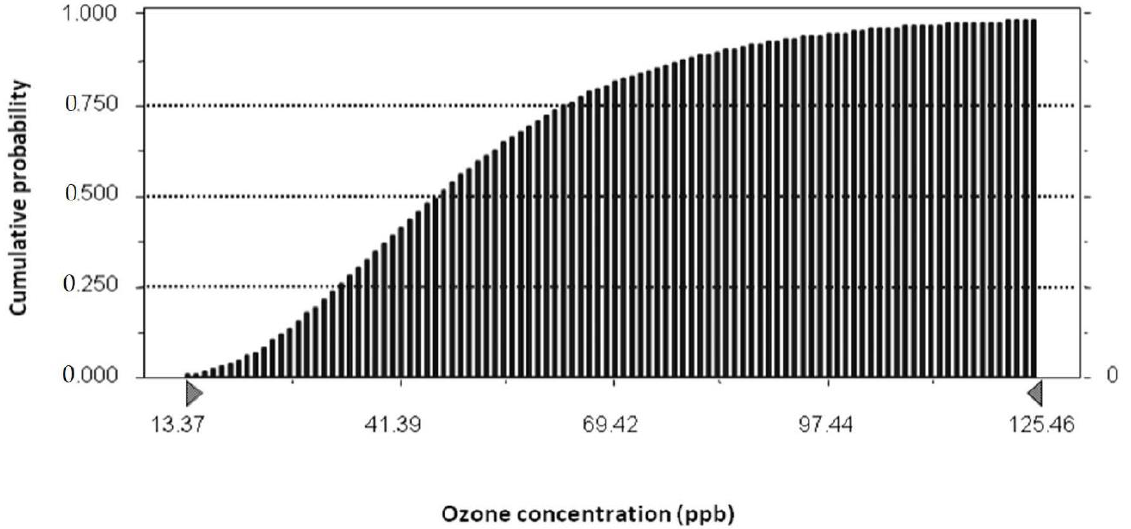
Figure 3. Monte Carlo analysis results reached after 20,000 simulation trials, showing the cumulative probability plot for ozone concentrations in a small room (15 m 3 ), with a penetration factor of ozone through the building shell of 100% and assuming the dryer was working as a continuous source of 5